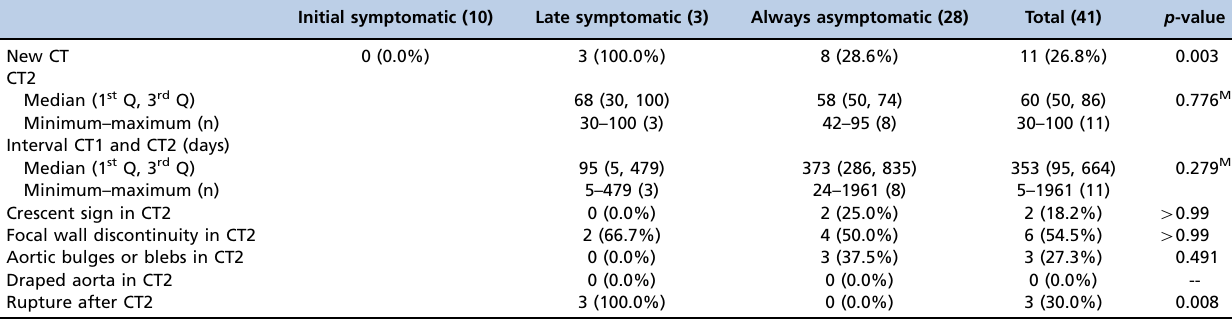
Table 5 - Characteristics of the second CT, and interval between the first (CT1) and second CTs (CT2).